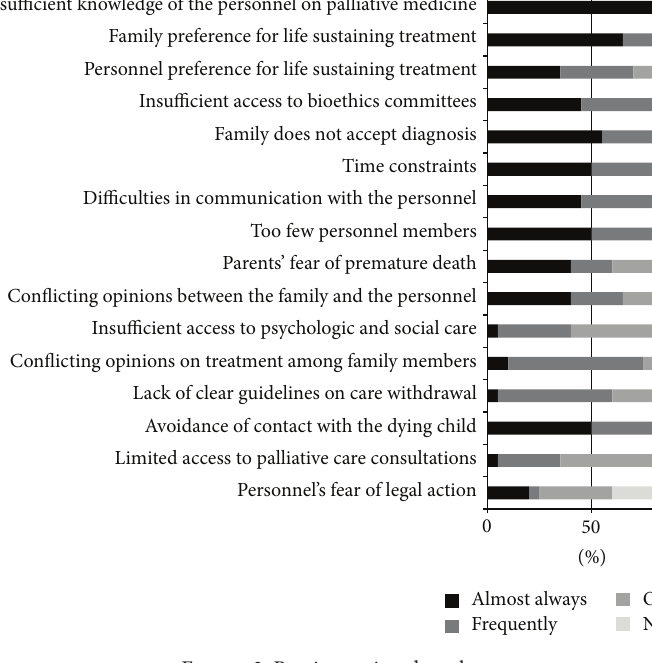
Figure 3: Barriers pointed out by